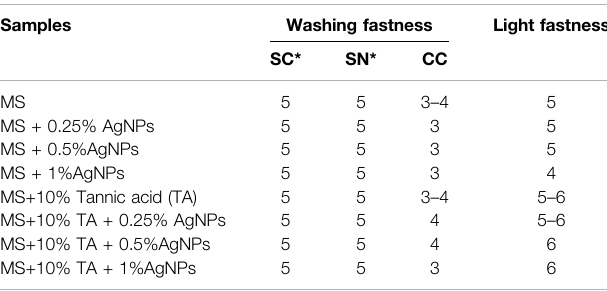
TABLE 3 | Colorimetric analysis of samples with and without AgNPs (MS 50% o.w.f.).